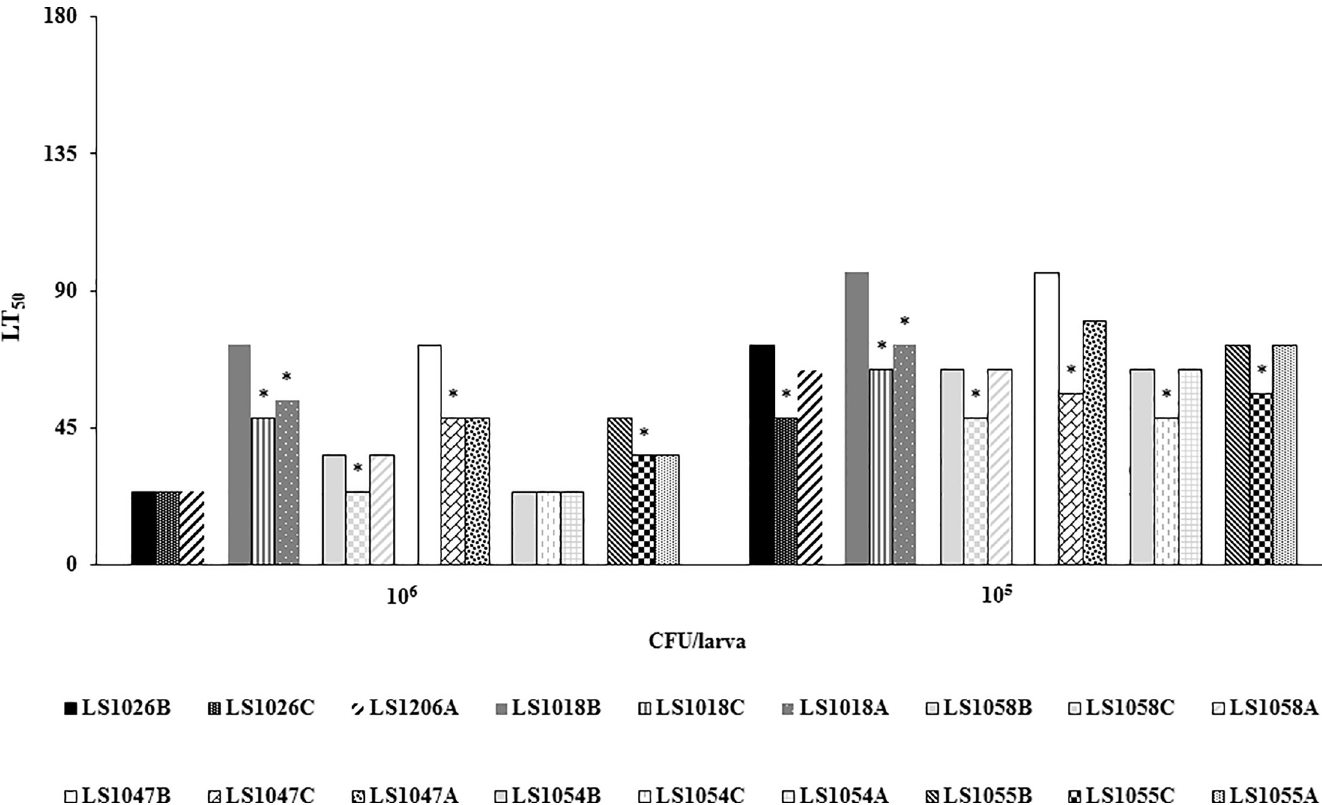
Fig 4. Mean survival of Galleria mellonella larvae following inoculation with L . monocytogenes grown in BHI, on apples and cantaloupe, averaged over all strain at the doses of (A) 10 6 CFU/larva and (B) 10 5 CFU/larva.